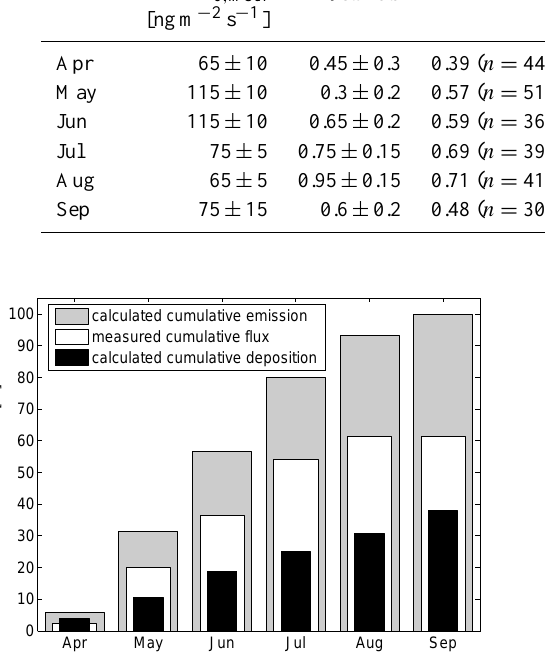
Figure 11. Cumulative methanol emission (calculated), deposition (calculated), and flux (measured) from April until September (years 2010–2013). The values have been scaled so that the maximum cu- mulative emission in September has the value of 100%. One should note that due to uncertainties in the calculations, substraction be- tween the cumulative emission and the cumulative deposition is un- equal to the cumulative flux (Table